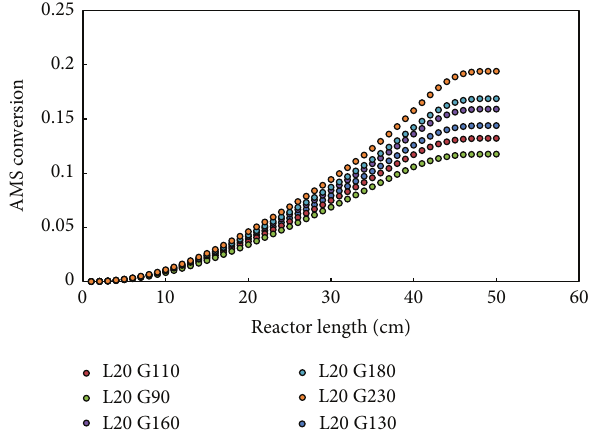
Figure 4: Calculated AMS conversion along the reactor length for a liquid flow rate of 20mL min −1 and various gas flow rates.